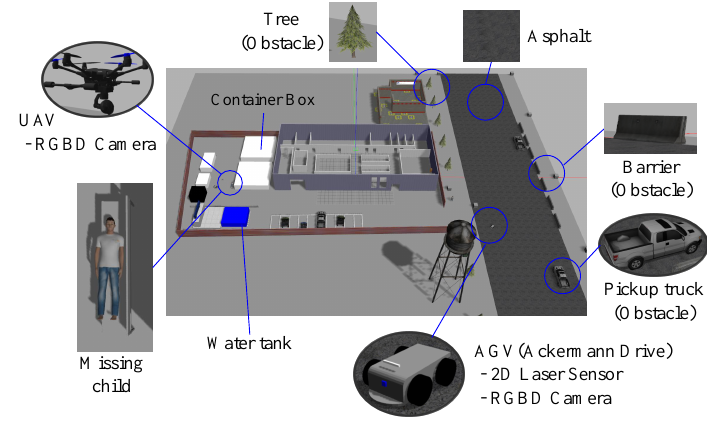
Figure 6. Simulation